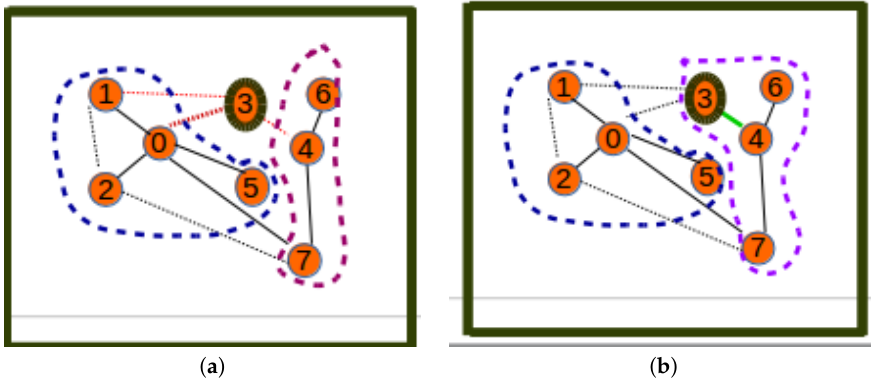
Figure 8. Relaxation: orphan nodes. ( a ) Inefficient network; ( b ) efficient network.